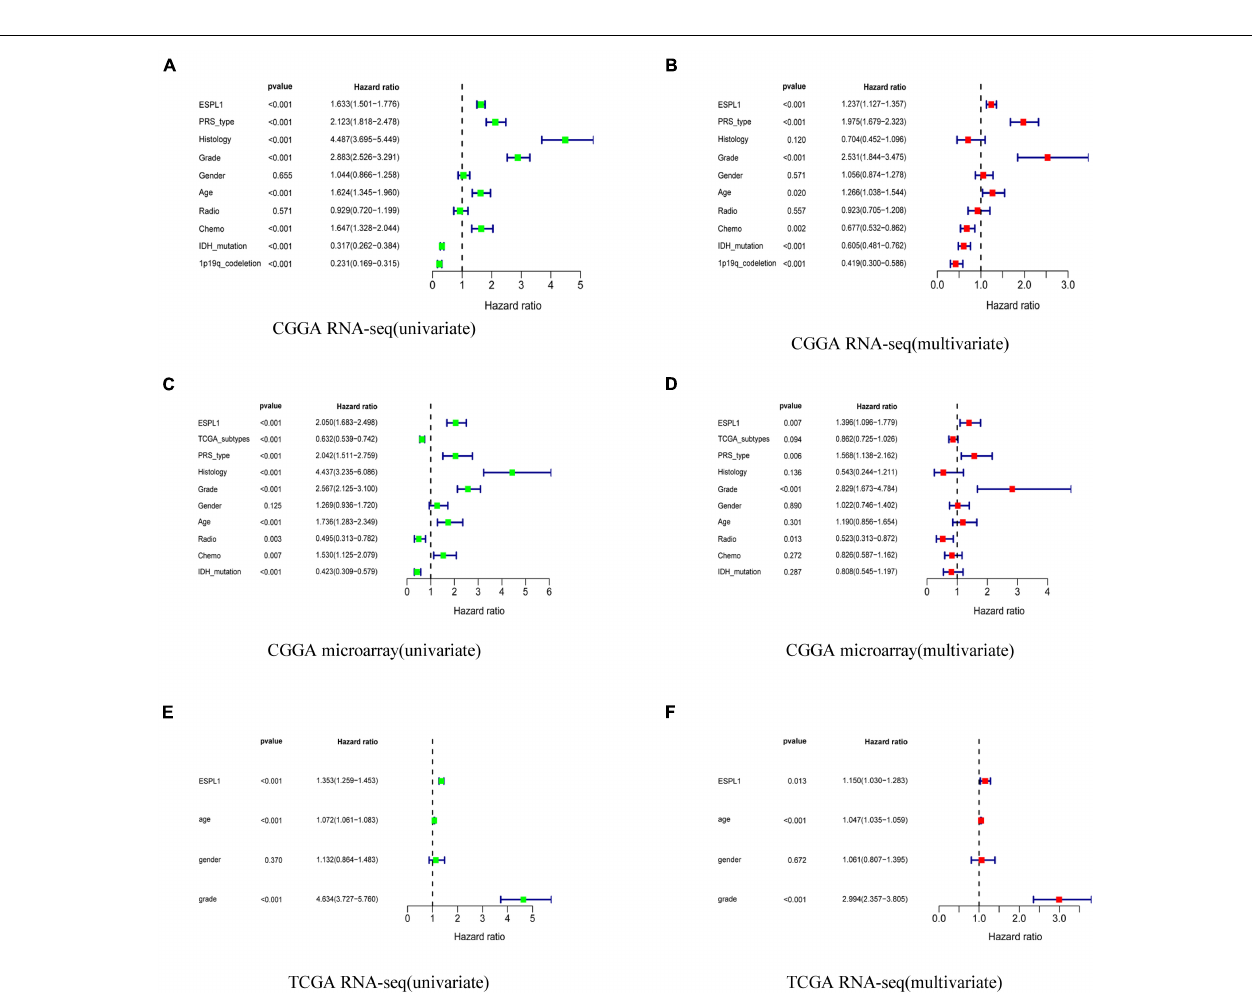
FIGURE 3 | Univariate analysis and multivariate analysis with Cox regression model. (A) Univariate analysis of CGGA RNA-seq database. (B) Multivariate analysis of CGGA RNA-seq database. (C) Univariate analysis of CGGA microarray database. (D) Multivariate analysis of CGGA microarray database. (E) Univariate analysis of TCGA RNA-seq database. (F) Multivariate analysis of TCGA RNA-seq database.